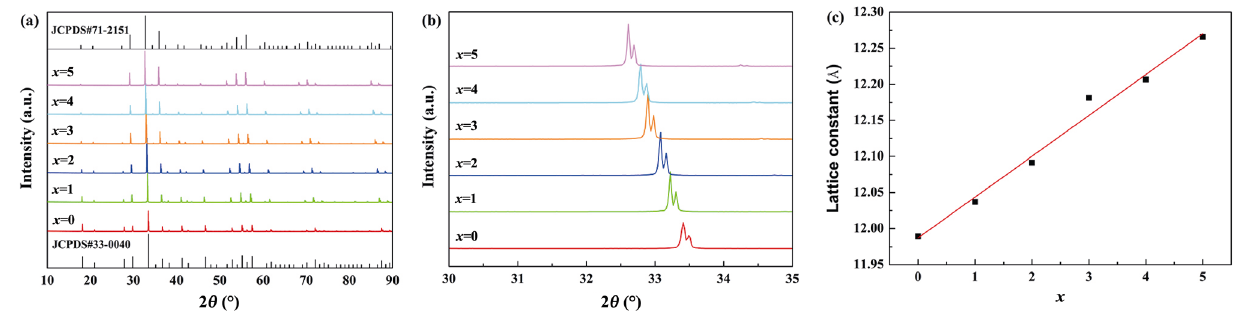
Fig. 2 (a) XRD patterns of Y 3 Al 5– x Ga x O 12 :Ce ( x = 0–5) ceramics, (b) expanded view of the 2 θ diffraction peak between 30° and 35°, and (c) calculated lattice constants from XRD diffraction